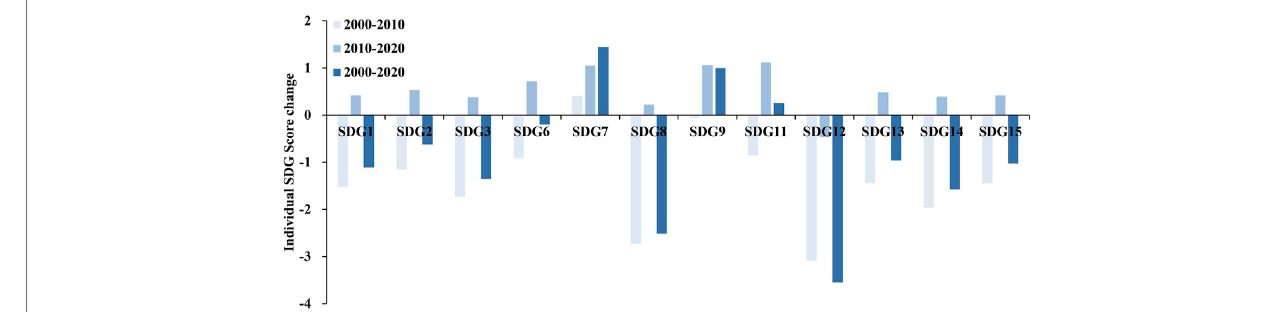
FIGURE 8 | Temporal changes in individual SDG scores in the Beijing-Tianjin-Hebei region.